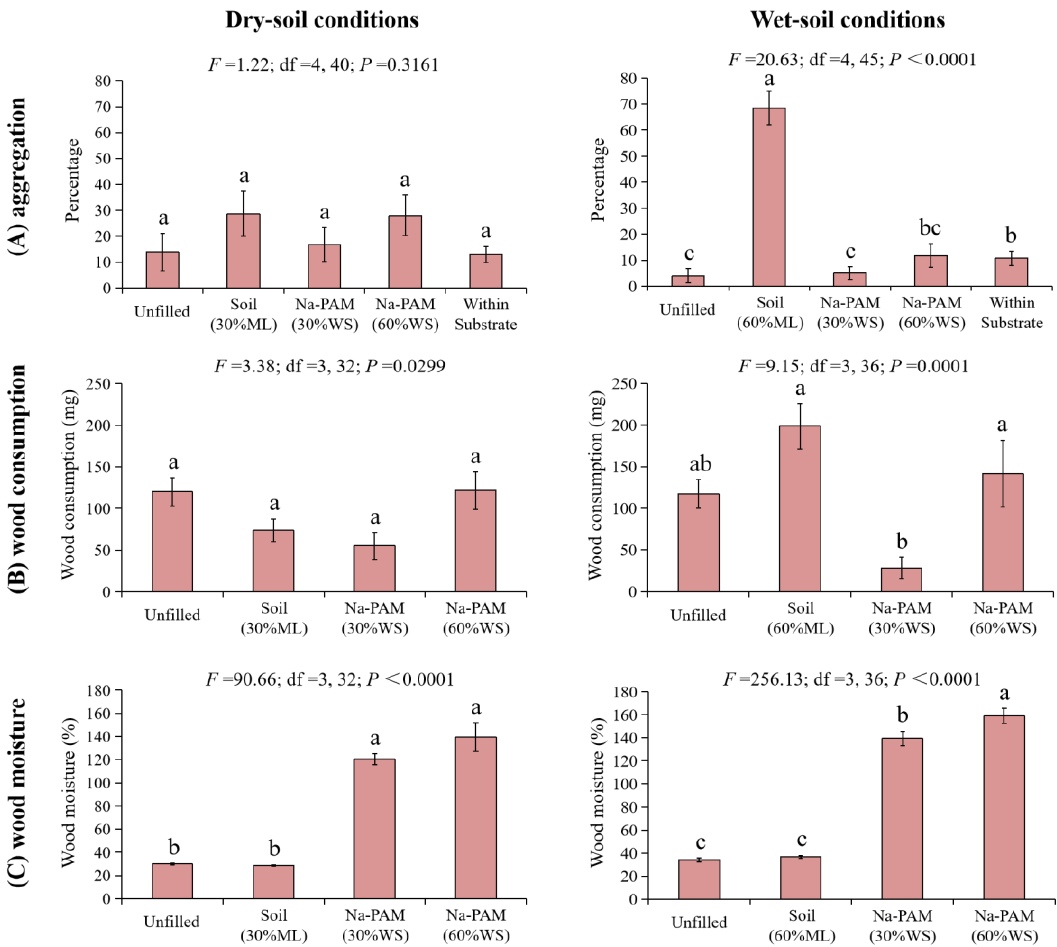
Figure 6. Results of the multiple-choice tests (under dry- or wet-soil conditions) to investigate the preference of termites to sodium polyacrylate (Na-PAM) filled in the void volume of baiting containers. Percentage of termites in each location ( A ), and wood consumption ( B ) and wood moisture (C) in each baiting containers are presented as mean ± SE. Different letters indicate significant differences ( p < 0.05). WS represents water saturation level.